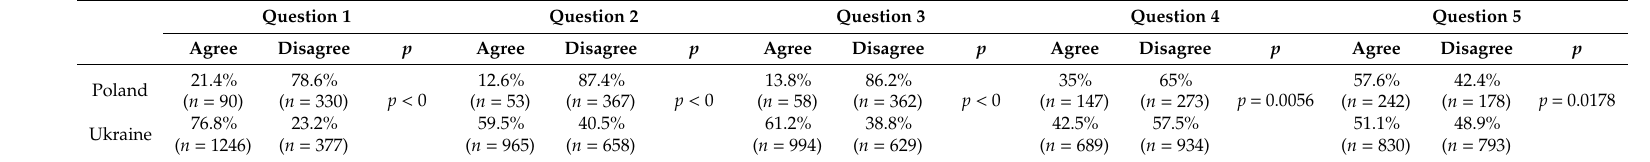
Table 3. Distribution of answers obtained in Questions 1 to 5.